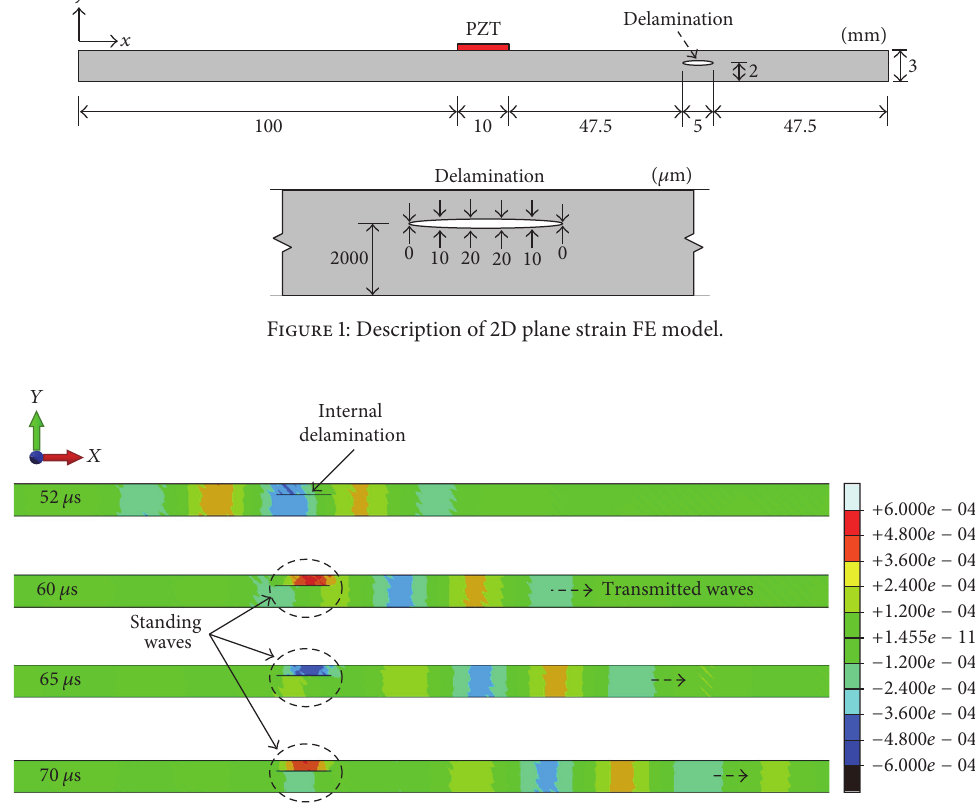
Figure 2: Representative out-of-plane velocities of Lamb wave propagation at 52 𝜇 s, 60 𝜇 s, 65 𝜇 s, and 70 𝜇